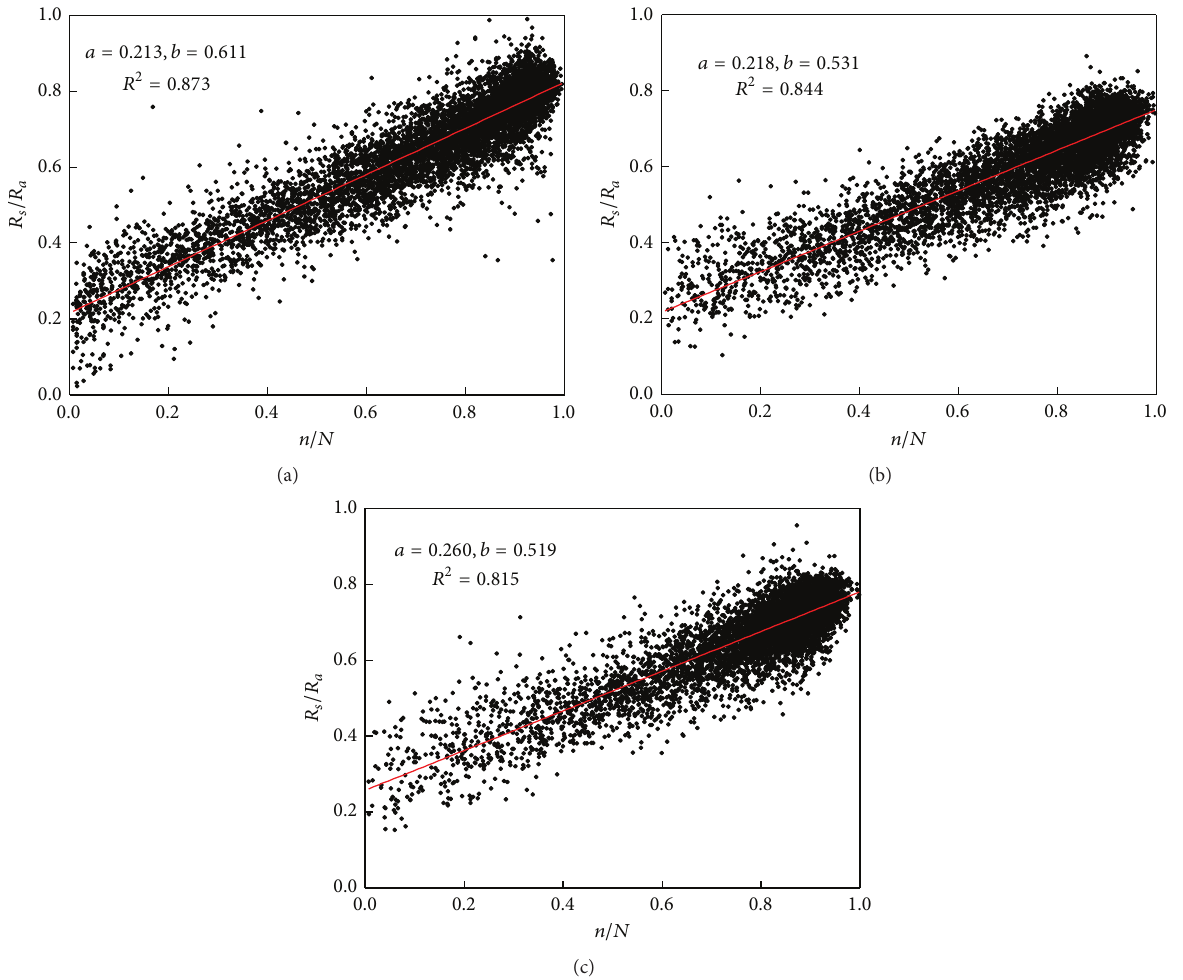
Figure 2: Calibration of the ˚Angstr¨om coefficients for the three radiation stations: (a) Gangcha station in the upper region, (b) Jiuquan station in the middle region, and (c) Ejina station in the lower